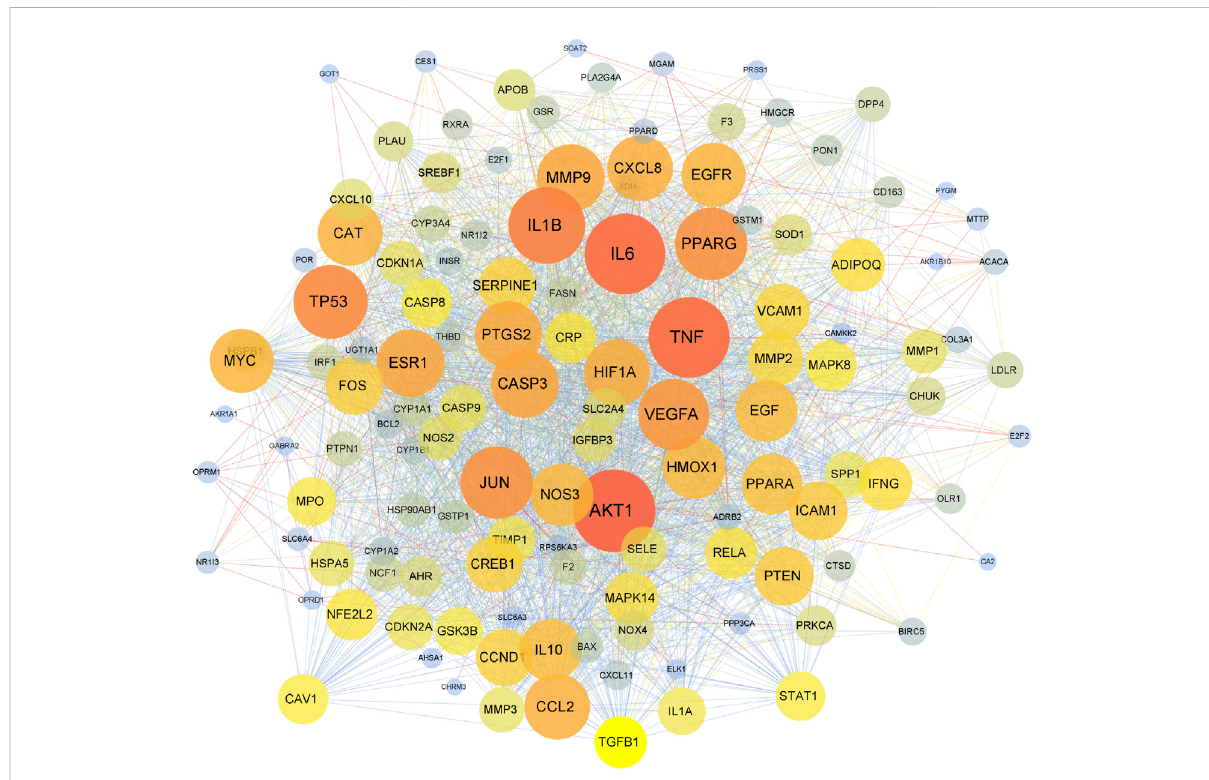
FIGURE 2 ThePPInetwork.Thenodesrepresentoverlappingproteins,andtheedgesrepresenttheinteractionsamongtheproteins.Thecolorandsizeof nodes represent the degree of the